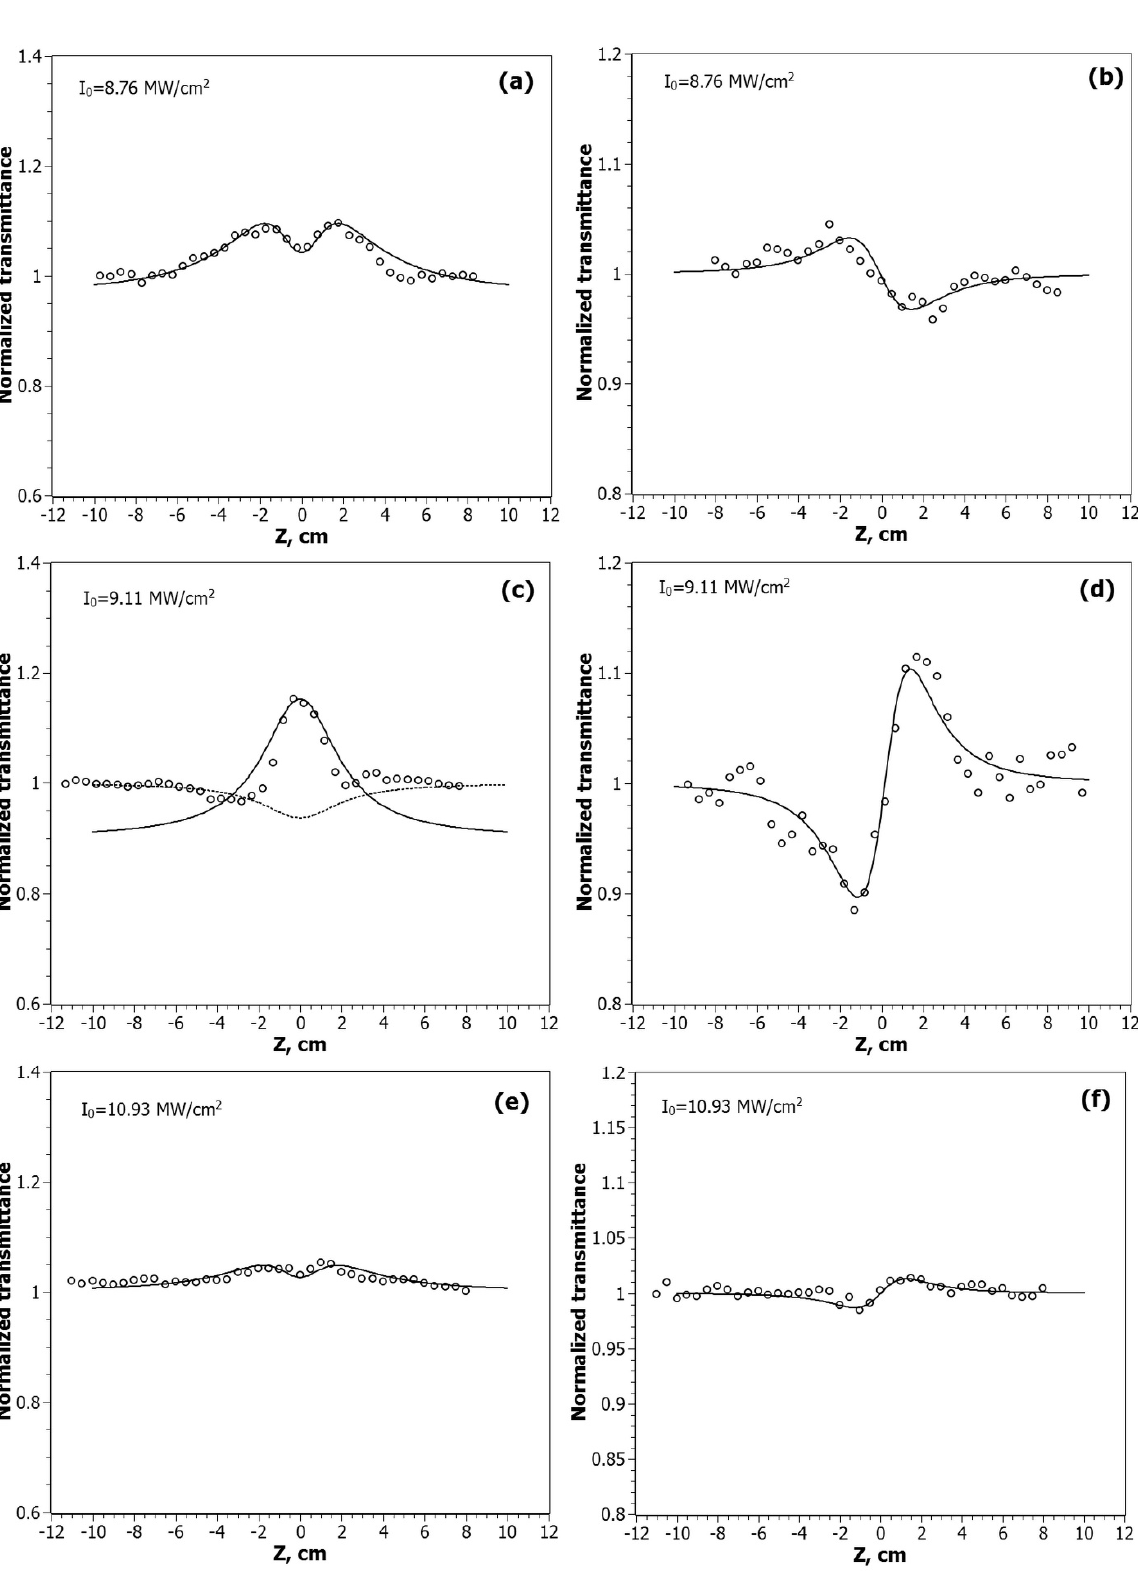
Figure 6. Z-scan profiles of the normalized transmittance measured for CdC8+Ag/Au NPs at the wavelength λ = 1064 nm in the OA scheme: CdC8+Ag/Au (1:1)—( a ), CdC8+Ag/Au (3:1)—( c ), CdC8+Au/Ag (3:1)—( e ); and the CA scheme: CdC8+Ag/Au (1:1)—( b ), CdC8+Ag/Au (3:1)—( d ), CdC8+Au/Ag (3:1)—( f ). Solid lines are theoretical fits of the experimental data.